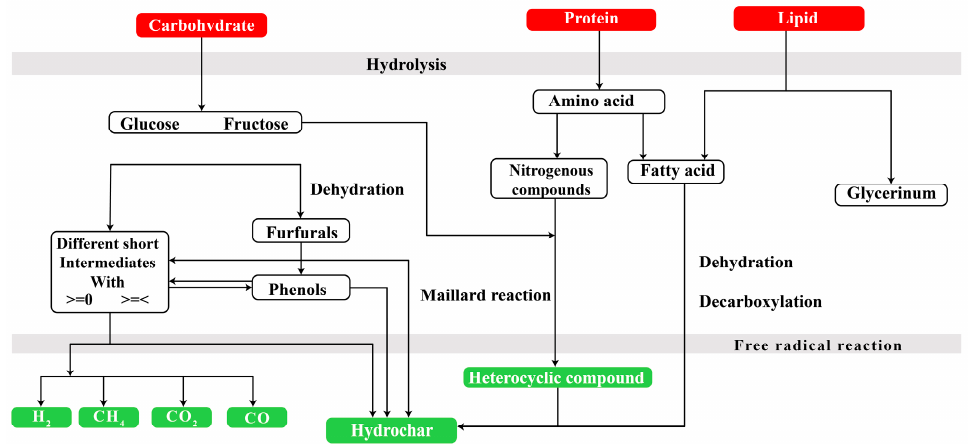
Figure 1. Simple reaction process of main components of kitchen waste (carbohydrate, protein, lipid) during hydrothermal carbonization.